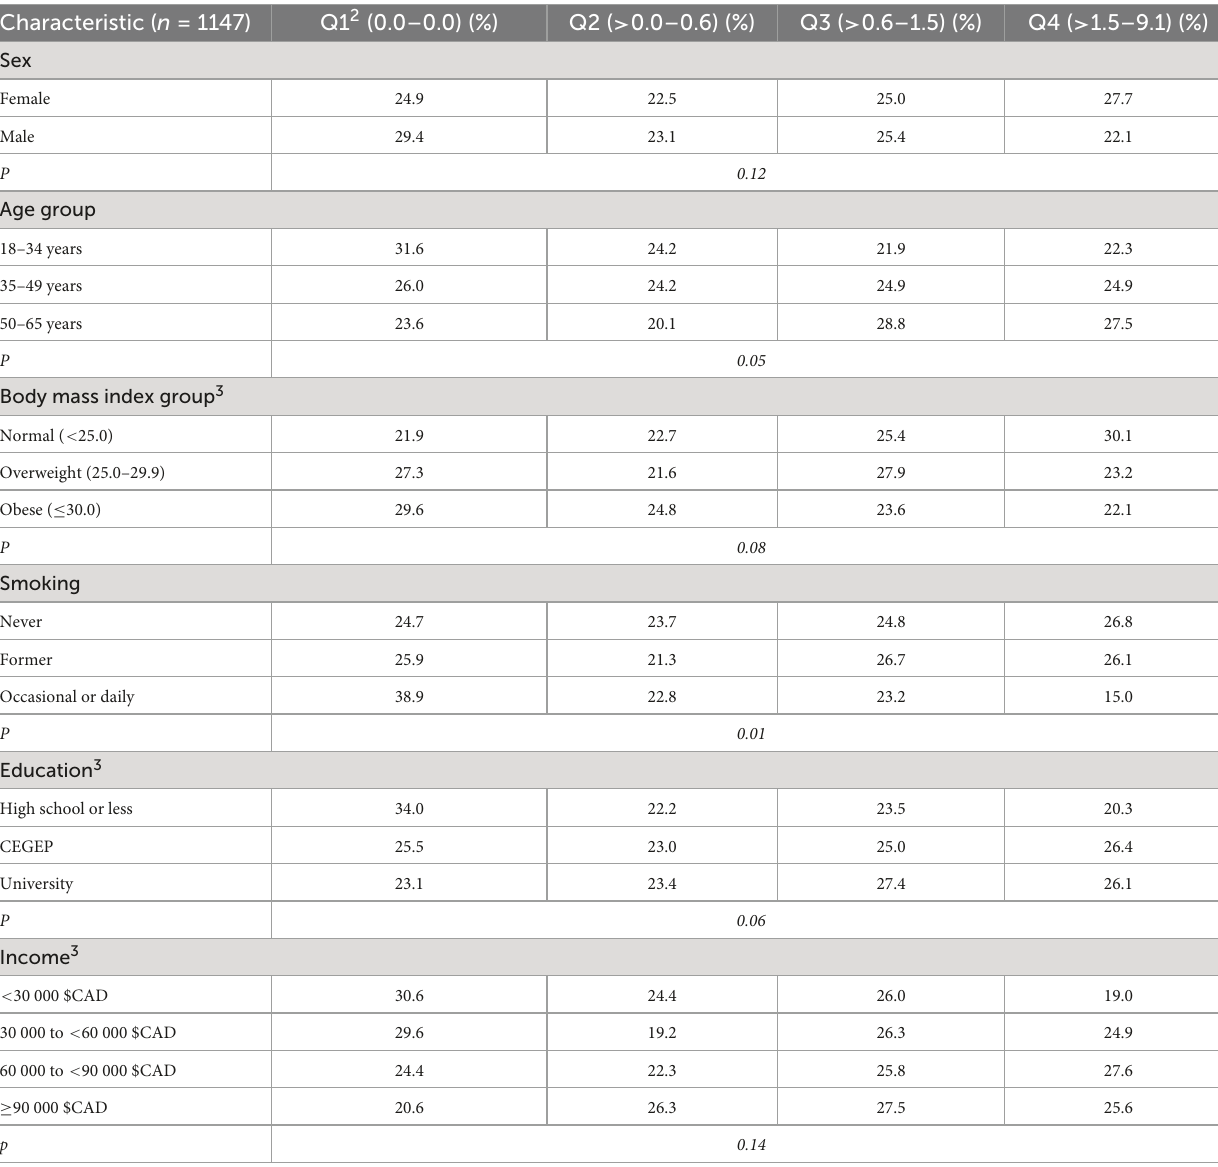
TABLE 2 Participants’ sociodemographic characteristics according to quarters of plant-based protein food intake 1 . Characteristic ( n = 1147)